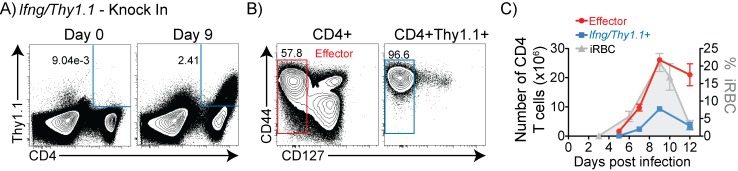
IFN-γ-producing effector cells expand and contract with kinetics similar to parasitemia.
Ifng/Thy1.1 Knock-In (KI) mice were infected with P. chabaudi infected RBC (iRBC). Splenocytes were harvested and analyzed by flow cytometry on various days post-infection (p.i.) and (A) were gated on CD4+
Ifng/Thy1.1
+, shown at day 0 and 9 p.i. Average percentages from three animals are shown on plots. (B) CD4+
Ifng/Thy1.1
+ (as gated in A) showing CD4+CD127- effector gate (red box) and Thy1.1+CD127- effector gate (blue box) at day 9 p.i. (C) Total numbers of CD4+ effector T cells and CD4+
Ifng/Thy1.1
+ T cells (as gated in B) per spleen overlaid with parasitemia curve (%infected RBCs/total RBCs). Data are representative of eight independent experiments with three animals per timepoint. Error bars represent SEM.